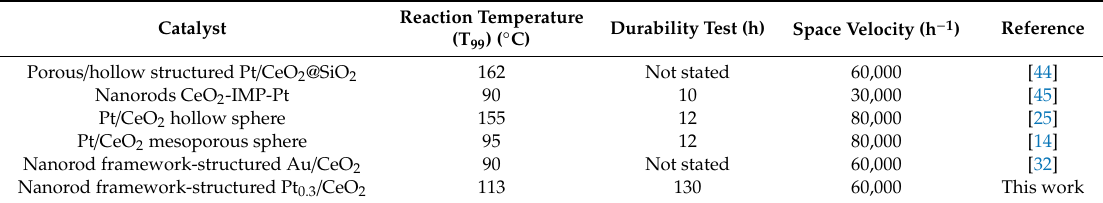
Table 1. Comparison of the catalytic performance of the nanorod framework-structured Pt / CeO 2 catalysts with those of previous reports.